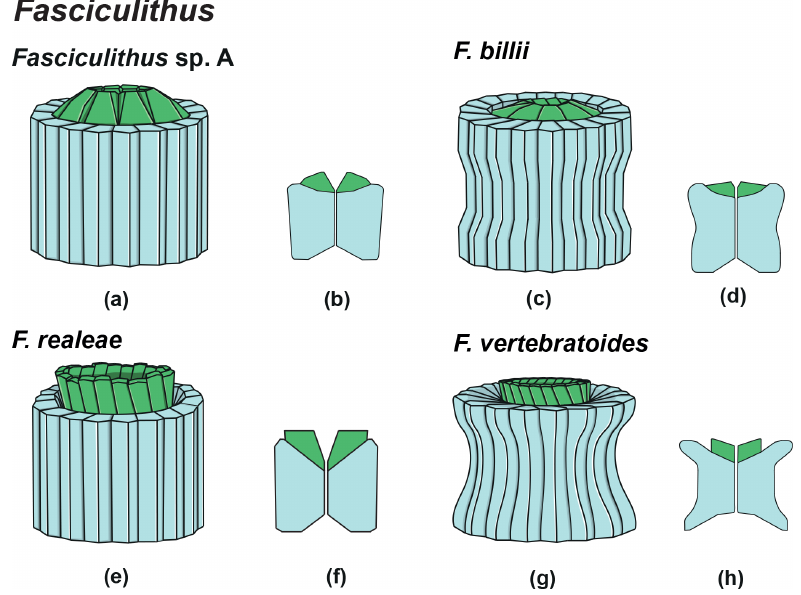
Figure 24. Overview of Fasciculithus column (light blue) and calyptra (green). Schematic drawing of the type species Fasciculithus sp. A. (b) Schematic cross section of F. involutus . (c) Schematic drawing of F. billii . (d) Schematic cross section of F. billii . (e) Schematic drawing of F. vertebratoides . (f) Schematic cross section of F. vertebratoides